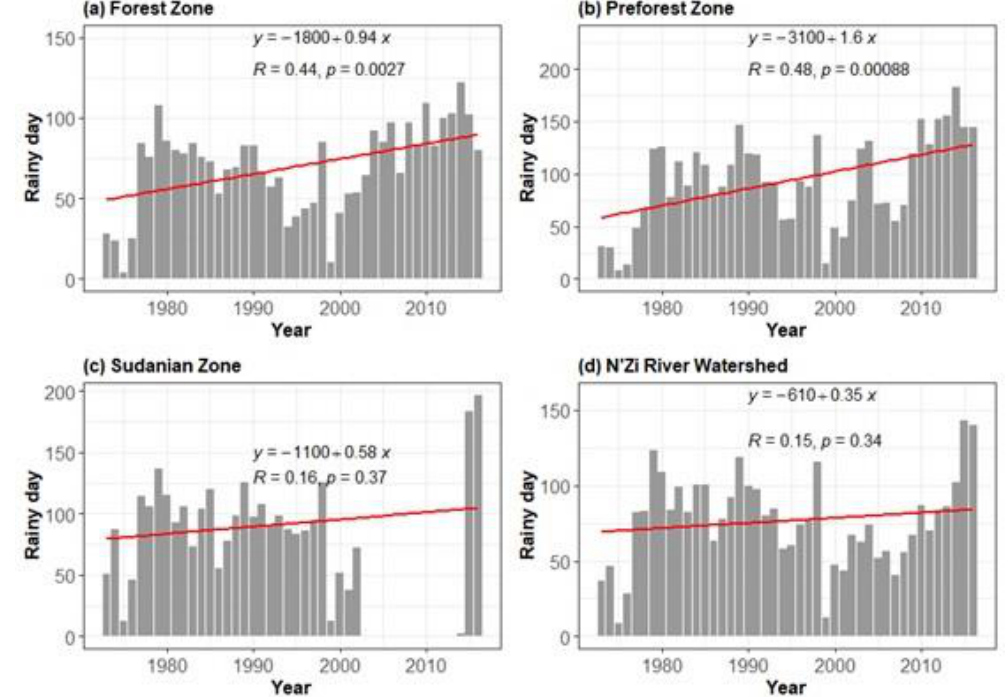
Fig. 2. Number of rainy days over the three ecoregions of the N’Zi River